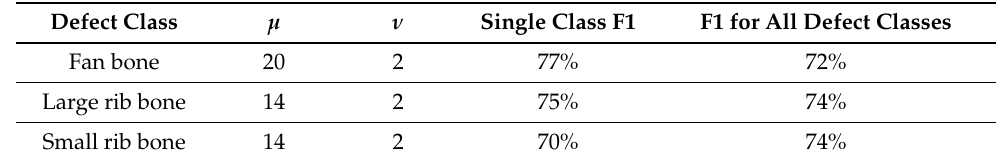
Figure 9. Defect segmentation F1-score for every class of defect in the dataset: fan bone, large rib bone, and small rib bone. The F1 value is averaged over all samples with a corresponding defect type. Table 2. Comparison of the best Chan–Vese parameters for different classes of defects. F1-score is separately calculated for all images with the same bone class and for all samples with a defect.